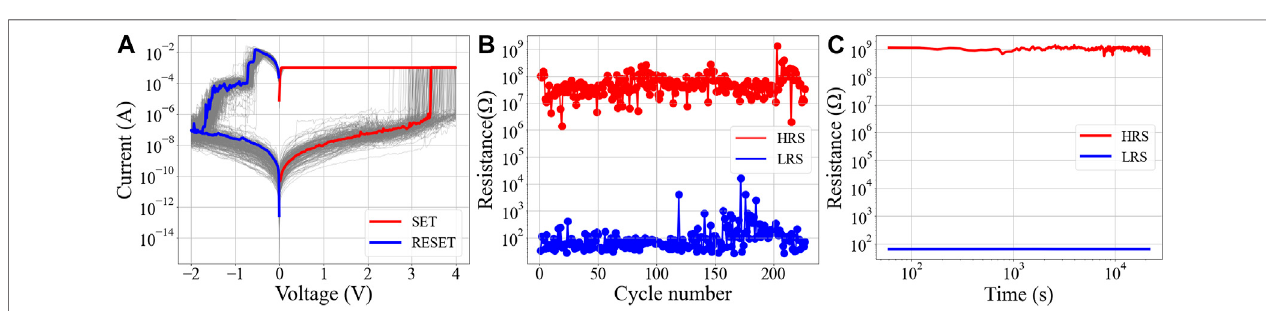
Frontiers in Nanotechnology |